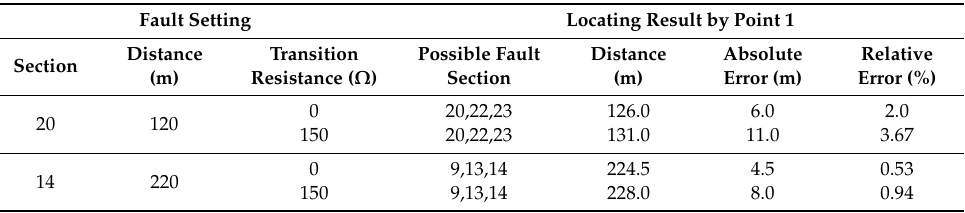
Table 10. Determination of the fault on section No.20 and No.14.